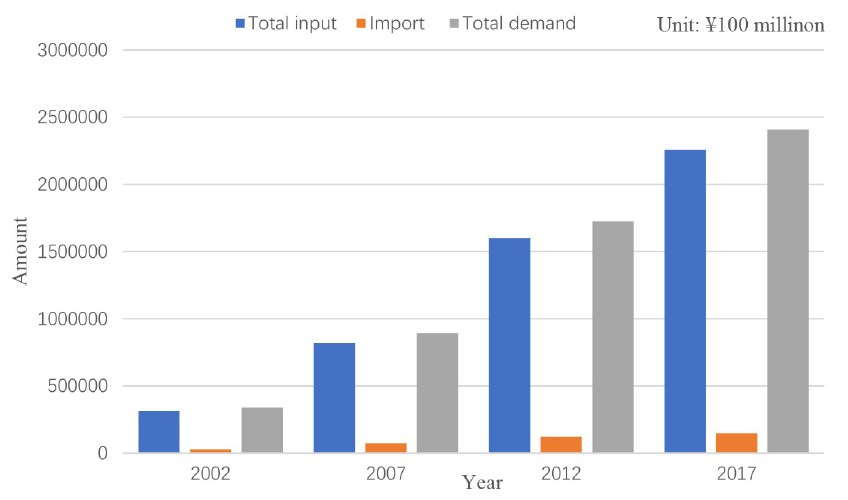
Fig 4. Quantity of total input, import, and total demand annual.